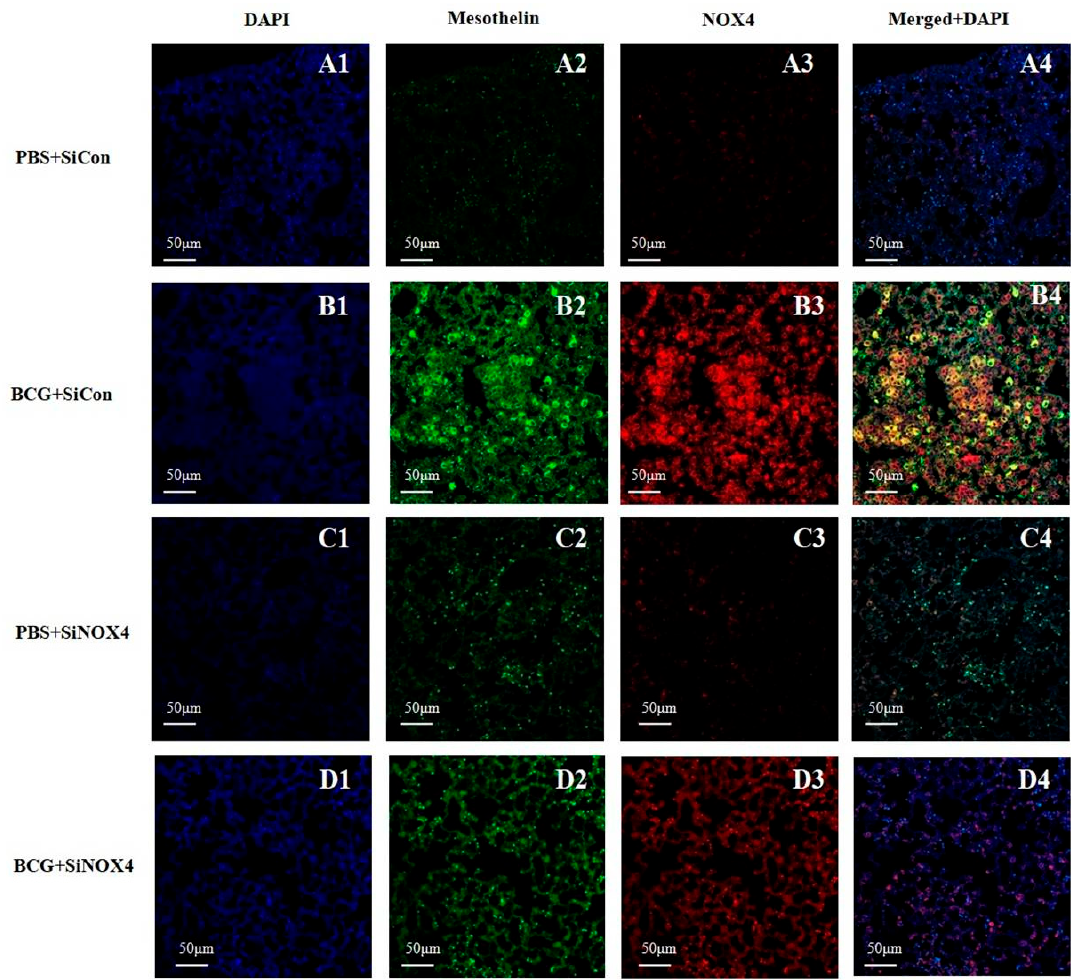
Figure 7. Activation of NOX4 and mesothelin deposition in a BCG-induced pleurisy mouse model. NOX4 and mesothelin (markers for PMCs) were subjected to immunofluorescence staining. A1 – D1 : DAPI staining. A2 – D2 : Immunofluorescence staining of mesothelin (green color). A3 – D3 : Immunofluorescence staining of NOX4 (red color). A4 – D4 : Overlays of immunofluorescence staining and DAPI staining, yellow areas represent colocalization of mesothelin and NOX4. DAPI, 4 ′ ,6-Diamidino-2-phenylindole dihydrochloride.